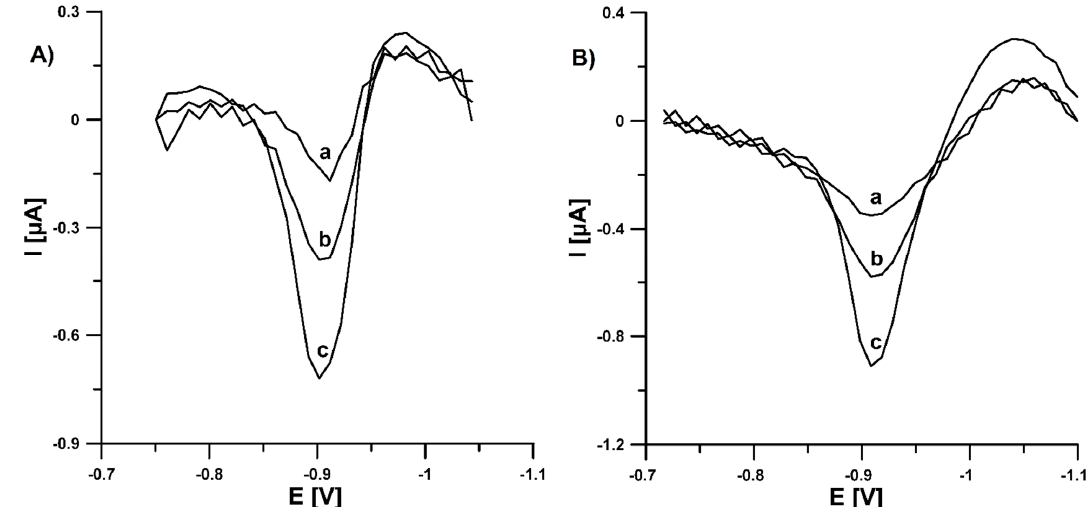
Figure 11. SWAdSVs obtained for the determination of U(VI) in SLEW-3 certified reference material ( A ): (a) 1 mL of sample, (b) as (a) + 1.0, (c) as (a) + 2.0 nM U(VI) and standard reference material 1640a ( B ): 91 μ L of sample, (b) as (a) + 1.0, (c) as (a) + 2.0 nM U(VI). The SWAdSV parameters: E dep and acc of − 0.8 V, t dep and acc of 180 s, f of 100 Hz, E SW of 100 mV and Δ E of 10 mV.